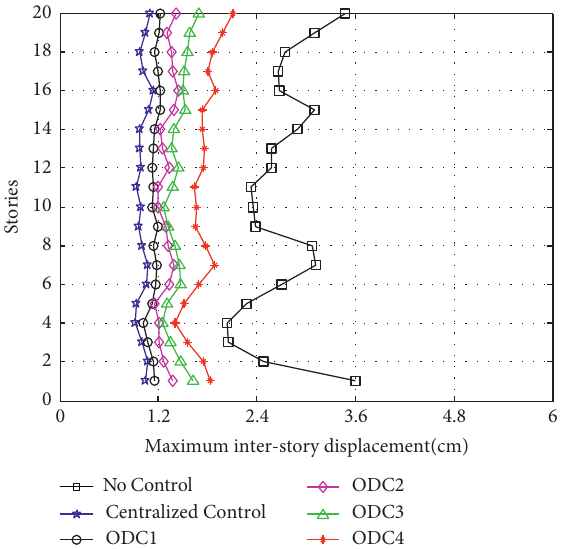
Figure 8: The maximum interstory displacements of time delay τ � 20ms. c G ODC 4 of overlapping decentralized H ∞ controller 4 is 0.1280.